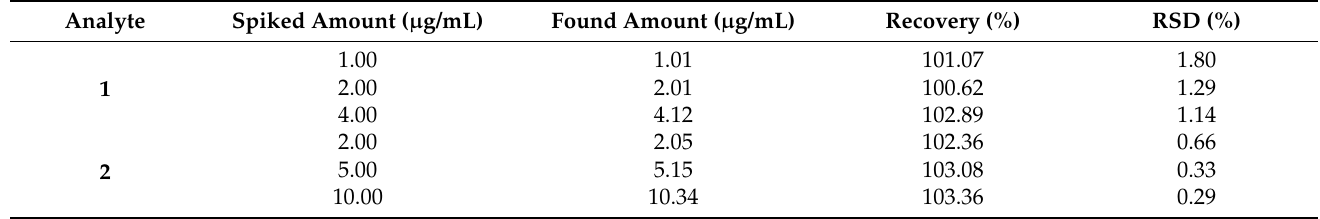
Table 2. Recovery (%) of the 19 marker components in the developed HPLC method ( n =